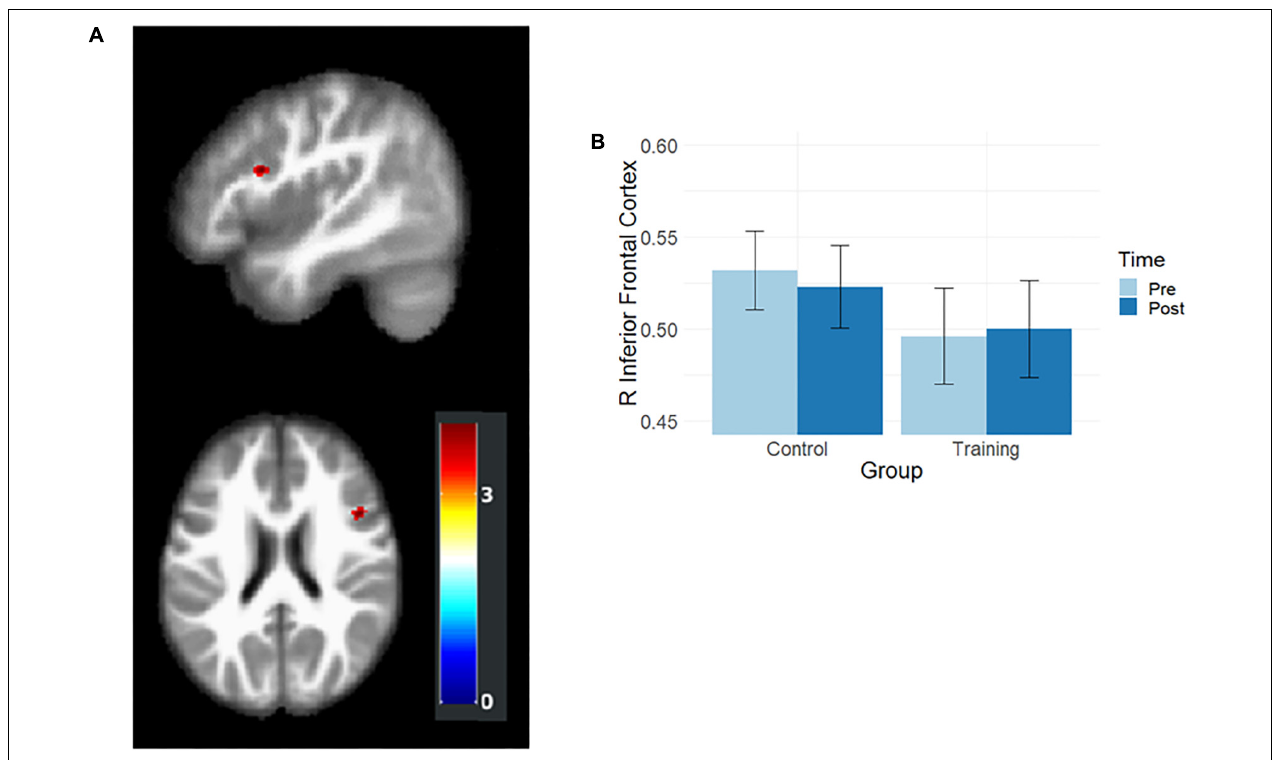
FIGURE 2 | Results of volumetric analysis. (A) Interaction effects were observed in rIFC. The map was illustrated at p < 0.001 (uncorrected) and k > 50. (B) The rIFC volume at the pre- and post-training assessments. After training, the rIFC volume increased in the training group and decreased in the control